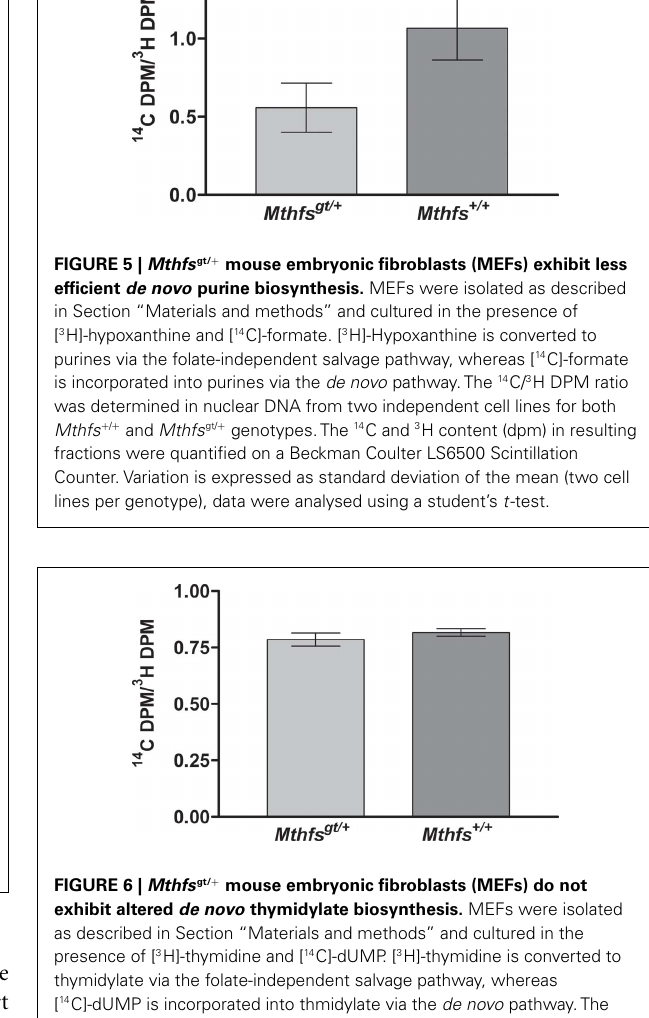
PLASMA OF Mthfs gt/ + MICE EXHIBITS ALTERED FOLATE LEVELS The effect of MTHFS depletion on plasma and tissue folate con- centrations were determined for Mthfs gt/ + and Mthfs + / +